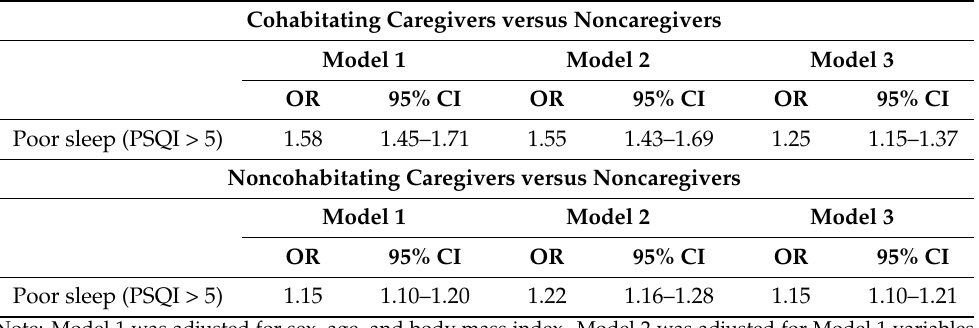
Table 3. Results of multivariable logistic regression showing significant associations between poor sleep quality and family caregivers of people with